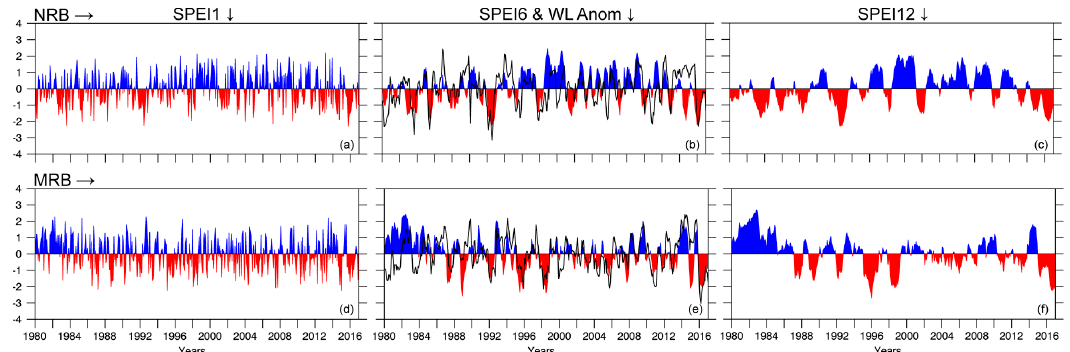
Figure 9. SPEI time series at 1-, 6-, and 12-month temporal scales ( a – c ) for the Negro ( top , NRB) and Madeira ( d – f ) (bottom, MRB) river basins. The blue (red) colour represents wet (dry) conditions. The black line represents the standardised anomalies of the water level (WL) recorded at the fluvial stations in Manaus ( b ) and Borba ( e ). Period: 1980–2016.